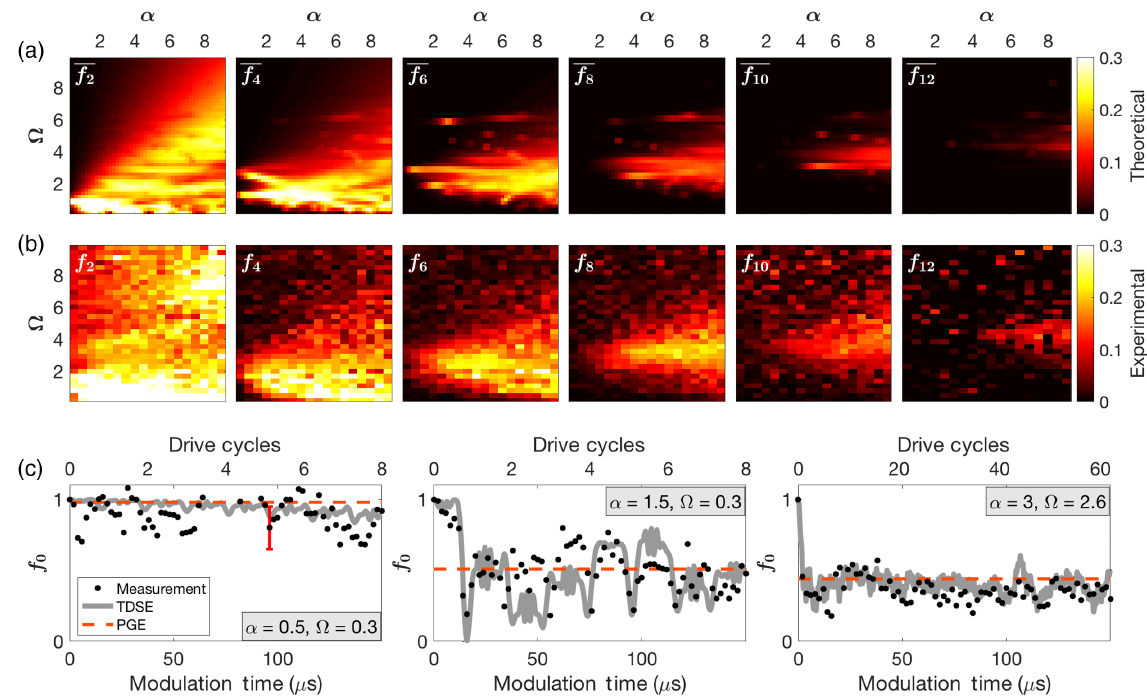
FIG. 2. Characterizing the prethermal periodic Gibbs ensemble. (a) PGE prediction for occupation of excited even bands as a function of the drive parameters α and Ω . (b) Measured atom number fraction in the central 40% of the same bands. All axes and color bars are the same as for the theory panels. (c) Measured f 0 versus modulation time for the first 150 μ s of the drive for three different values of ð α ; Ω Þ all for vanishing interactions. Dashed line shows PGE prediction; solid line shows TDSE prediction of the fluctuating evolution of a spatially homogeneous noninteracting system. Each point represents a single run; error bar shows representative estimated fractional error due to shot-to-shot number fluctuation. For these data, the optical lattice is immediately quenched back to the initial ten E R static lattices at the indicated modulation time and then band